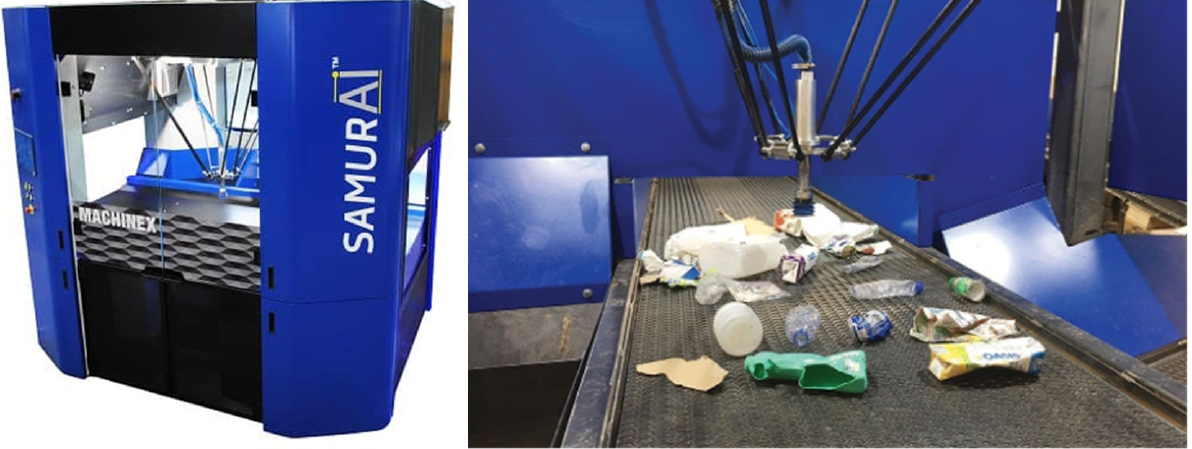
Figure 4. AI-based sorting robots, extracted from: https://www.machinexrecycling.com/products/samurai-sorting-robot/ (last accessed on 12 February 2022).